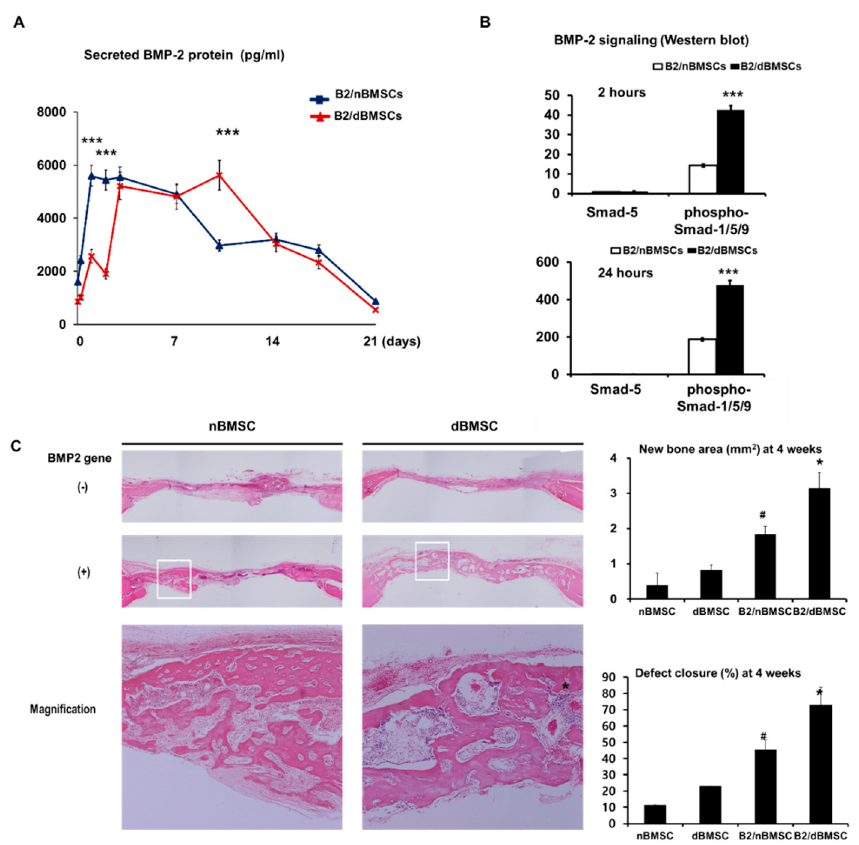
Figure 3. Effect of diabetes on BMP-2 production and bone regeneration of BMSCs. ( A ) BMP-2 secretion of AdBMP-2-transfected nBMSCs vs that of AdBMP-2-transfected dBMSCs. (‘‘*’’indicates a significant difference, with * p < 0.05, ** p < 0.01, and *** p < 0.001 (paired t-test)) ( B ) BMP-2 signaling pathway analyzed by western blotting. (‘‘*’’indicates a significant difference, with * p < 0.05, ** p < 0.01, and *** p < 0.001 (paired t-test)) ( C ) Bone regeneration by AdBMP-2-transfected nBMSCs vs that by AdBMP-2-transfected dBMSCs. (‘‘*’’ indicates a significant difference from the other groups (ANOVA with Tukey’s post hoc test, p < 0.001) and ‘‘#’’ indicates a significant difference from the other groups).., non-diabetic bone marrow stromal cells, nBMSC; AdBMP-2-transfected nBMSCs, B2/nBMSCs; diabetic BMSCs, dBMSCs; AdBMP-2-transfected dBMSCs; B2/dBMSCs. Reproduced from Park et al.